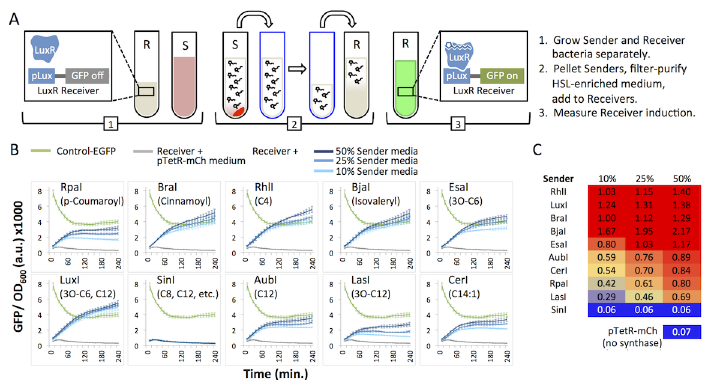
Fig 4. Induction of the LuxR receiver with HSL-enriched media from Senders. (A) The cartoon illustrates the experimental approach for Receiver inductions. Sender (S) culture medium is separated from pelleted Sender cells, filtered, and diluted (see Table 1), and used to induce Receiver cells. (B) GFP/OD 600 of Sender-media-treated LuxR receiver cells. “Control-EGFP” bacteria carry a plasmid that constitutively expresses EGFP from a pLac promoter. EGFP and optical density (OD 600 ) are measured every 10 minutes for 240 minutes (4 hours). Graphs show means of triplicate wells (bars, standard deviation). (C) The heat map shows GFP/ OD 600 values after 240 min of induction, normalized to the GFP/ OD 600 value for Control-EGFP.